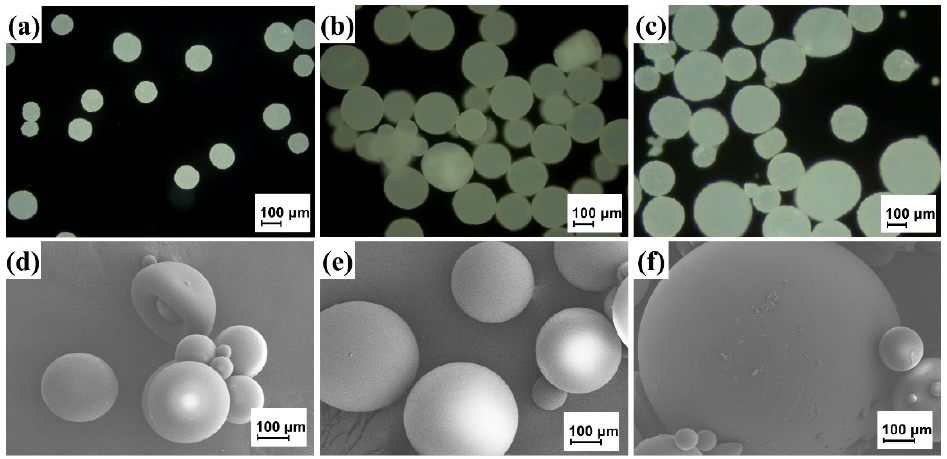
Figure 5. ( a – c ) OM images of the microcapsules with different BDO dosages. ( d , e ) SEM images of the microcapsules with different BDO dosages. ( a , d ) 8.33 wt%, ( b , e ) 15.38 wt%, ( c , f ) 18.52 wt%.